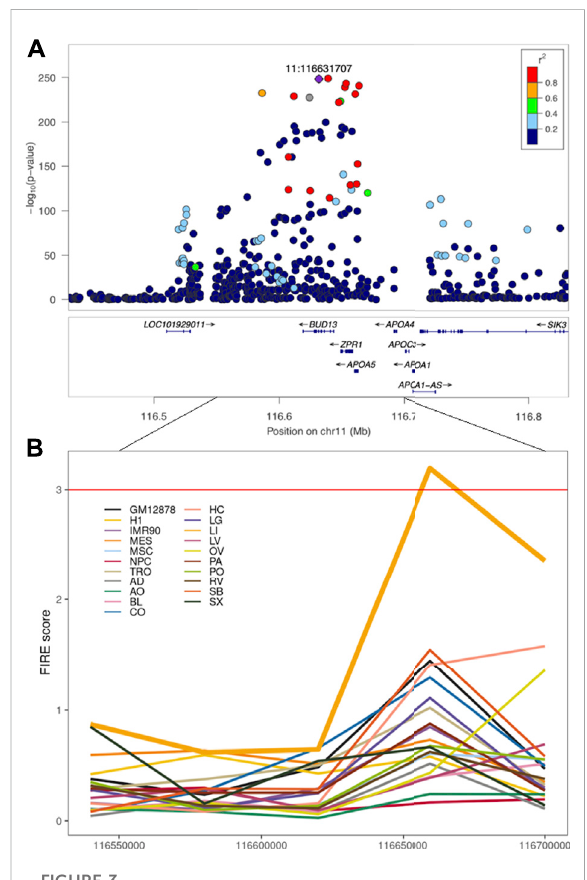
FIGURE 3 Triglycerides-GWAS signals near a liver-speci fi c FIRE region. (A) Locuszoom plot of GWAS results for triglycerides (Willer et al., 2013). (B) FIRE scores across 21 human cell lines and primary tissues examined in Schmitt et al. Each color represents a tissue or cell line. GM12878: the GM12878 lymphoblastoid cell line (LCL), H1: the H1 human embryonic stem cell line, IMR90: the IMR90 human lung fi broblast cell line, MES: the human mesendoderm cell line, MSC: the human mesenchymal stem cell lines, NPC: the human neural progenitor cell line, TRO: the human trophoblasts-likecellline,AD:thehumanadrenalglandtissue,AO: the human aorta tissue, BL: the human bladder tissue, CO: the human dorsolateral prefrontal cortex tissue, HC: the human hippocampustissue,LG:thehumanlungtissue,LI:thehumanliver tissue, LV: the human left ventricle tissue, OV: the human ovary tissue, PA: the human pancreas tissue, PO: the human psoas muscle tissue, RV: the human right ventricle tissue, SB: the human small bowel tissue, SX: the human spleen